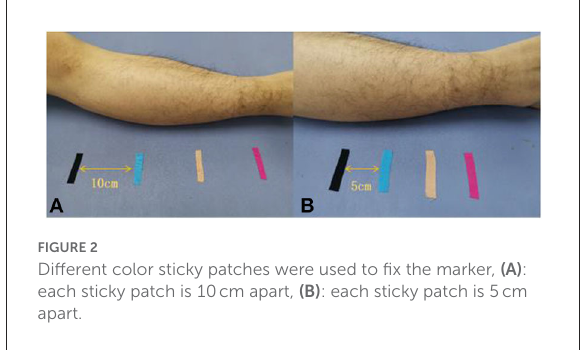
FIGURE4 Active movement stage: the treatment process is completely dominated by the patients themselves, and the difficulty of training is gradually increasing.